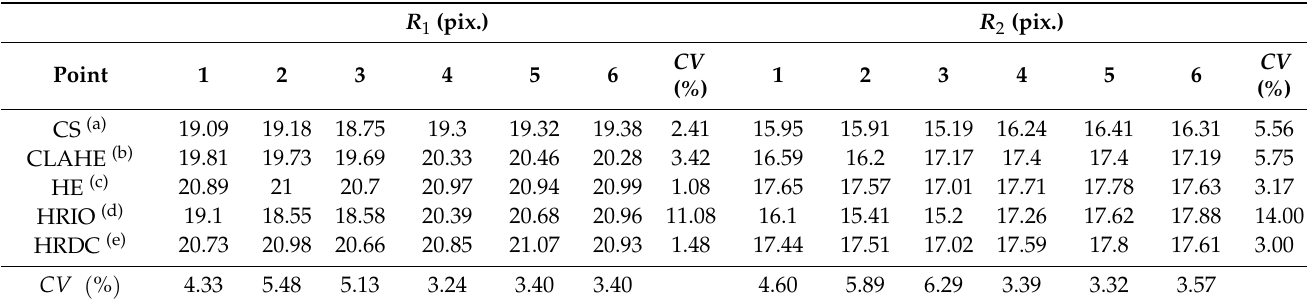
Table 2. Two-directional radii, R 1 and R 2 , for identification of object points. R 1 (pix.) R 2 (pix.)